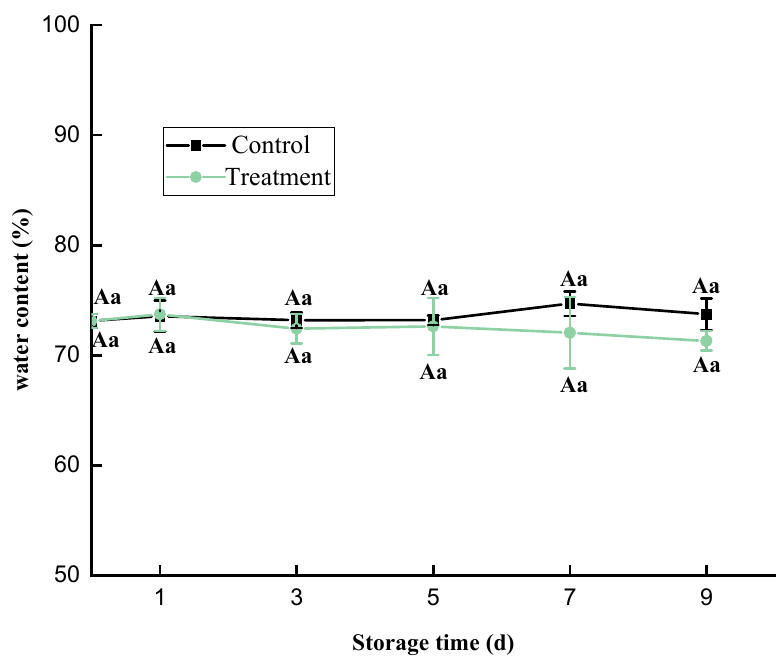
Figure 3. Changes in the water content of Trachinotus ovatus during refrigerator storage. Within the same group, different lowercase superscripts indicate significant differences ( p < 0.05). Among different groups, different capital letter superscripts indicate significant differences ( p < 0.05).